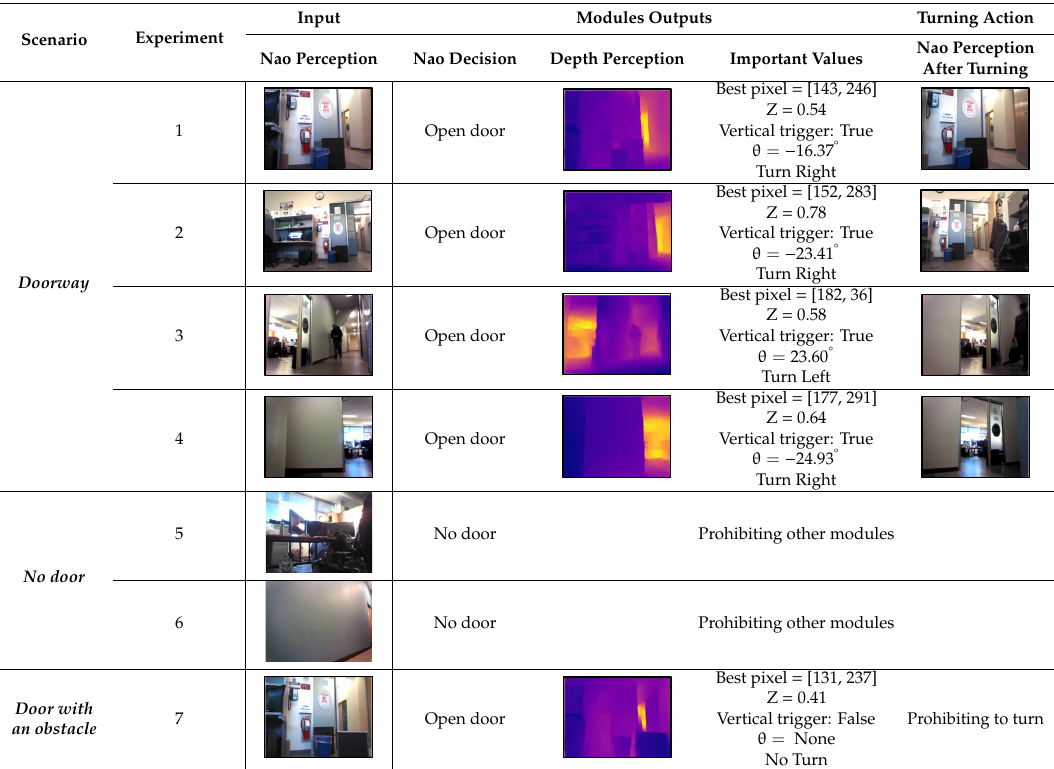
Figure 8. Examples of three different scenarios for evaluating 3Ds-system with Nao in real-time experiments. ( a ) Doorway; ( b ) no door; ( c ) doorway with an obstacle. Table 4. Results of real-time experiments with Nao at Autonomous Intelligent System Laboratory (AISL) in Simon Fraser University (SFU), BC. Scenario